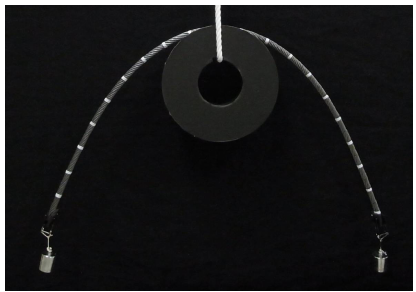
Figure 3. Resulting curvature when a 0.20 kg weight was added to each end of the rope.